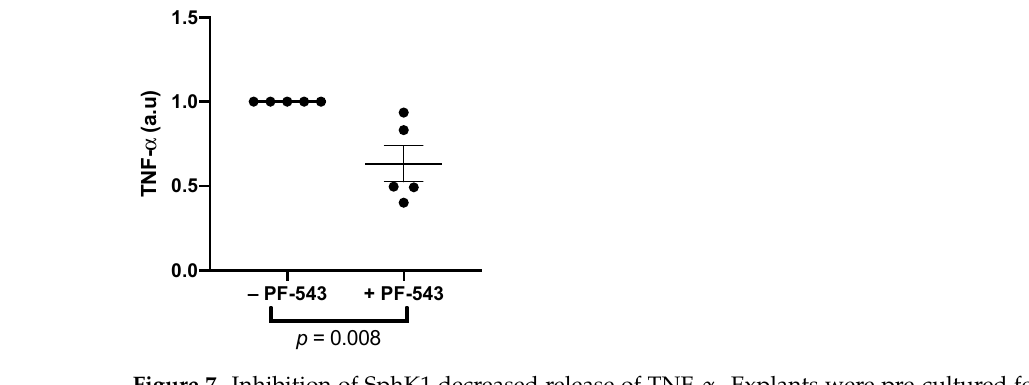
Figure 7. Inhibition of SphK1 decreased release of TNF- ⍺ . Explants were pre-cultured for 4 days prior to treatment with 1 μ M PF-543 or a no-treatment control for 48 h. Supernatants were centrifuged at 15,000 RPM for 15 min prior to quantification of TNF- ⍺ using a multiplex array. Results were normalized against total protein mass, and normalized values were graphed as a ratio of change from the untreated control explant cultures. ( n = 5, Mean ± SEM, Mann–Whitney test).